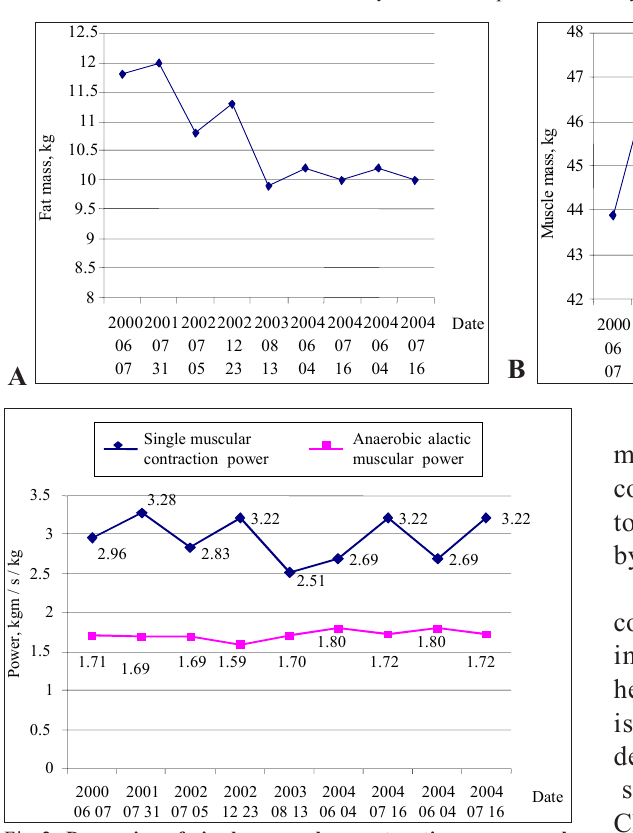
Fig 2. Dynamics of single muscular contraction power and anaerobic alactic muscular power indices of highly-skilled heptathlon athlete A. S. in